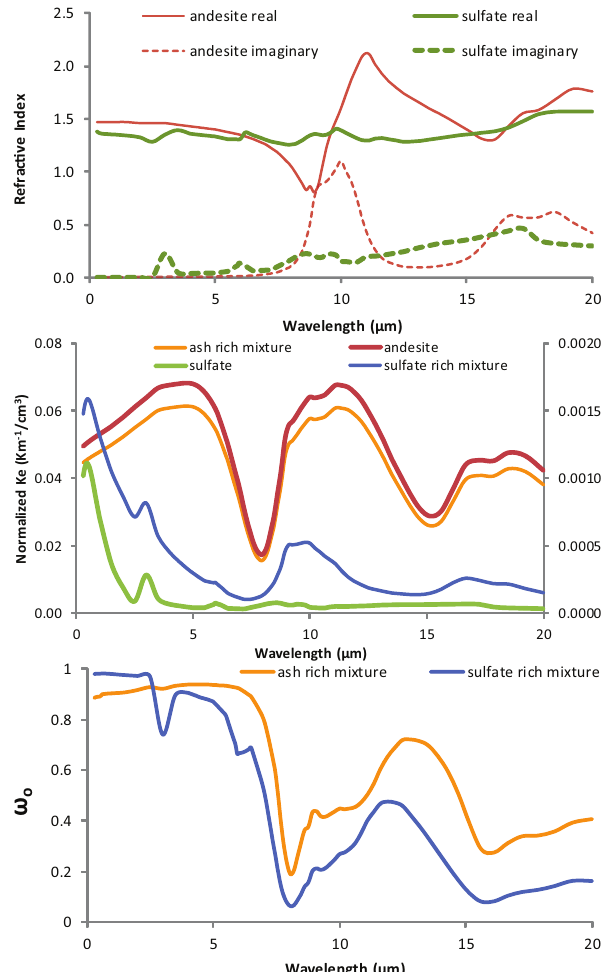
Fig. 1. (a) Spectral dependence of refractive indices of ash and sulfate. (b) Concentration normalized extinction coefficients ( K e ) versus wavelength for an ash rich mixture containing an ash to sul- fate ratio of 9 to 1 and an effective radius for ash R eff = 5 µm compared to andesite with R eff = 5µm (right axis) and for a sul- fate rich mixture containing an ash to sulfate ratio of 1 to 9 and an effective radius for ash R eff = 1 . 5µm compared to sulfate with R eff = 0 . 5µm (left axis). (c) Single scattering albedo ( ω 0 ) versus wavelength for an ash rich mixture containing an ash to sulfate ratio of 9 to 1 and R eff = 5µm and a sulfate rich mixture containing an ash to sulfate ratio of 1 to 9 and R eff = 1 .